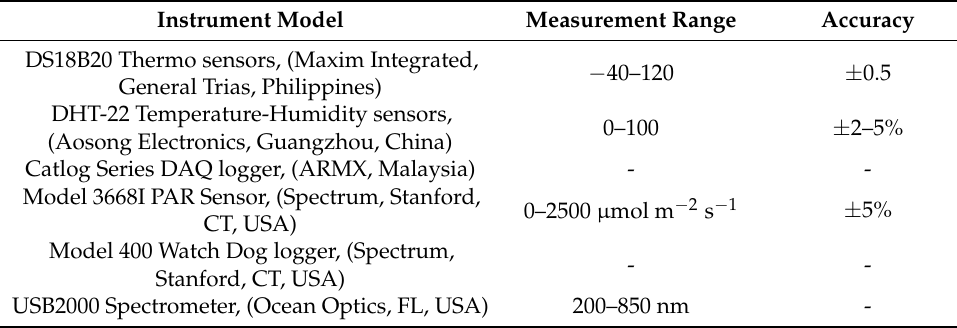
Table 1. The details of the instruments. Instrument Model Measurement Range